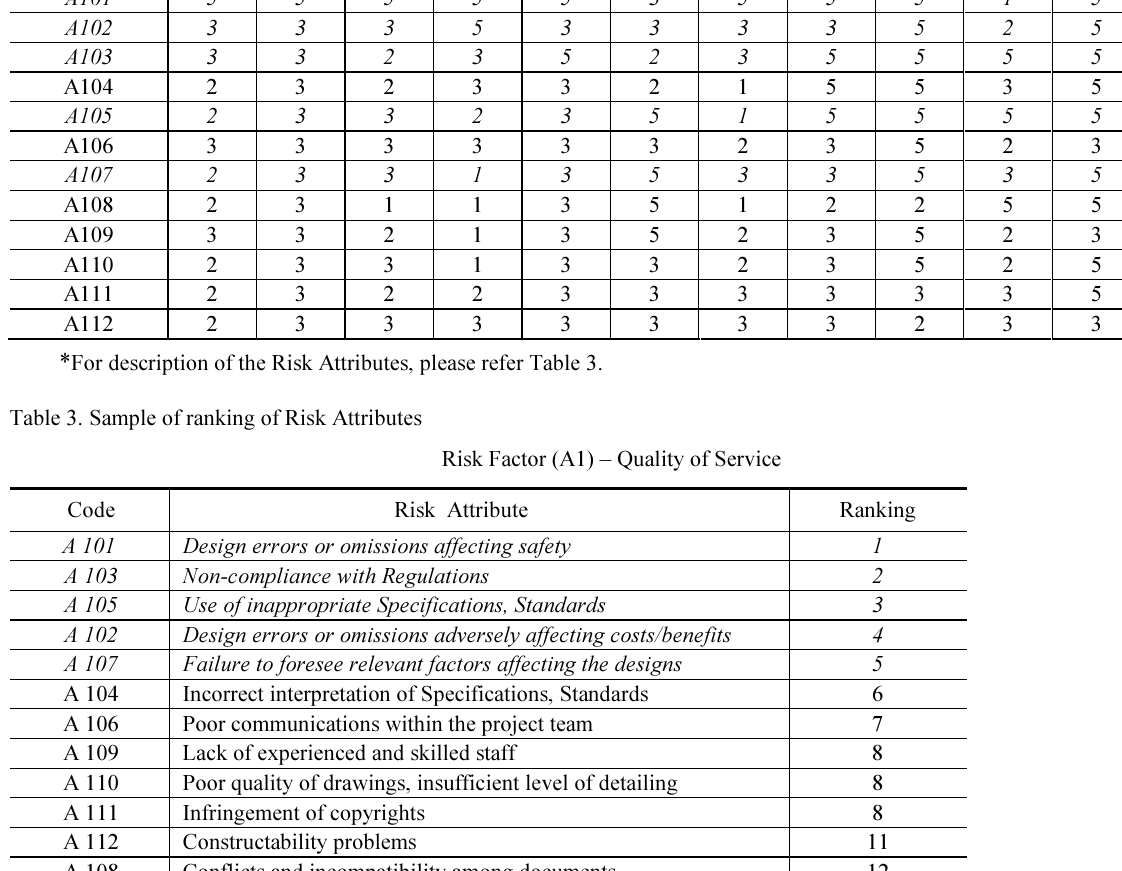
Table 2. Sample results of questionnaire survey